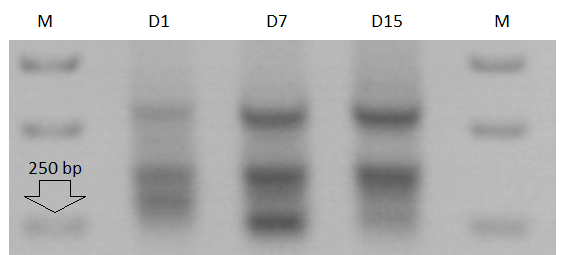
Fig. 1. PCR amplification of Pl 16 with the expected size of 250 bp (as indicated by arrow) using ORS1008 primer pairs in D1, D7 and D15 differential lines. The D7 and D15 differential lines showed the expected band. M: 1Kb marker